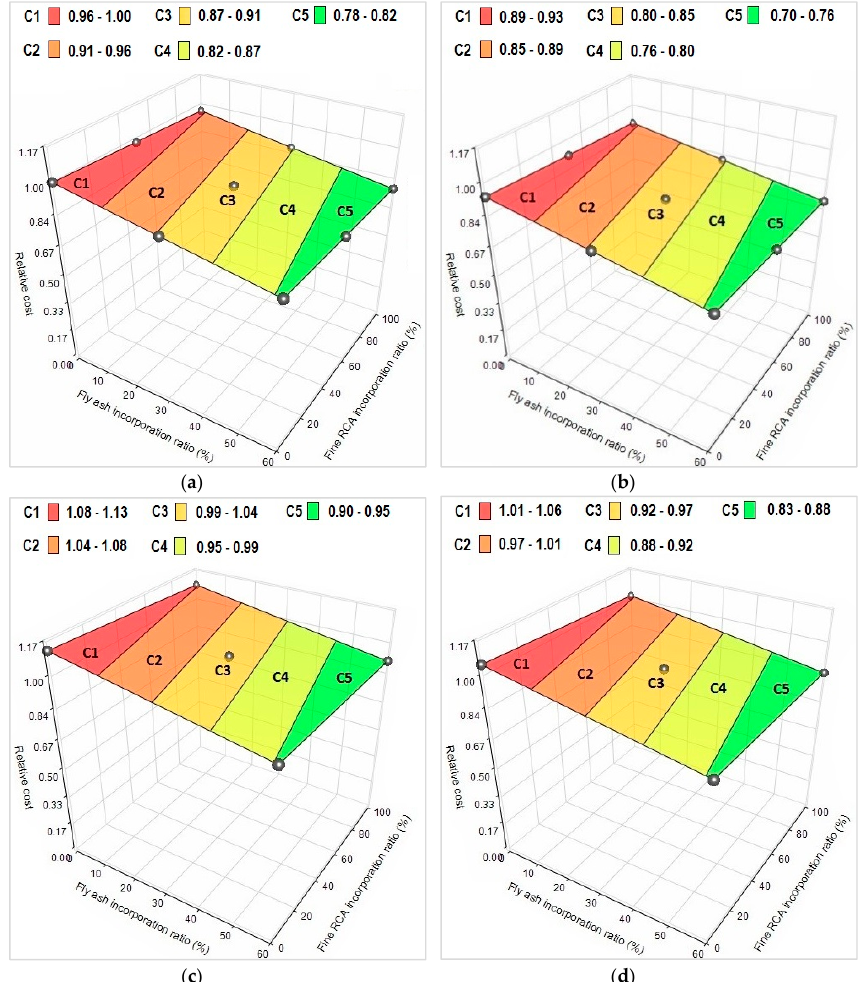
Figure 4. Relative cost of 1 m 3 concrete mixes with increasing incorporation levels of fine RCA and FA with ( a ) 0% and 0% ( b ) 100% and 0%, ( c ) 0% and 1%, and ( d ) 100% and 1% of coarse RCA and SP, respectively. All figures are relative to the reference concrete “M1”. (Black dots represent relative results; shades represent relative cost).